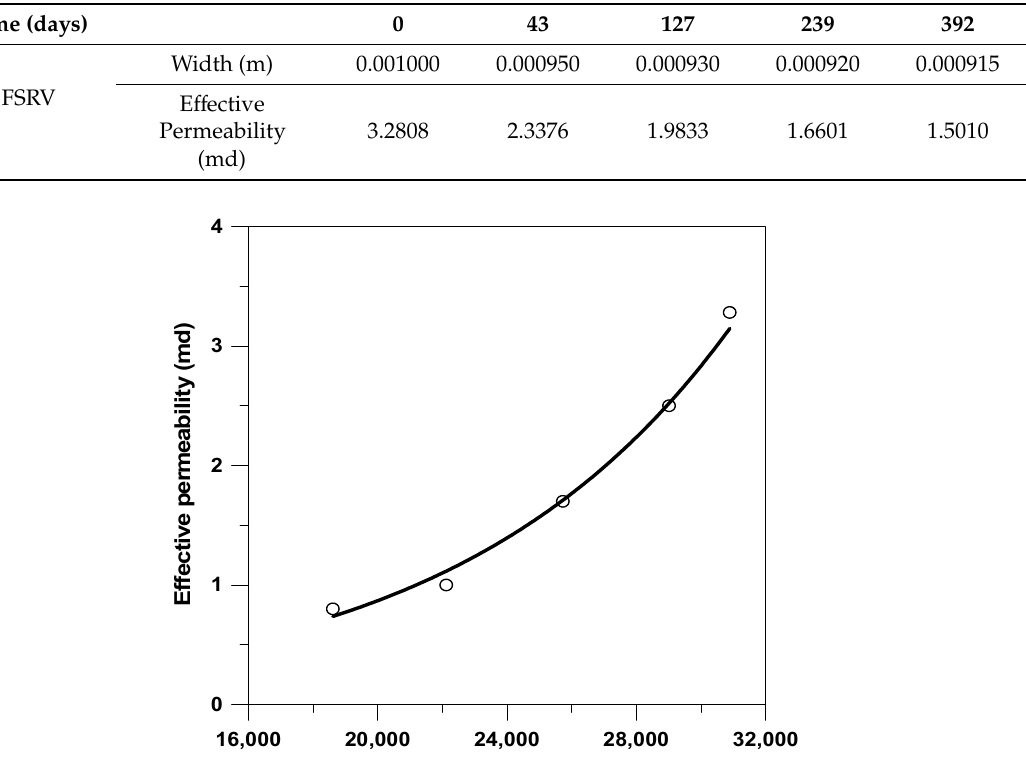
Table 4. Hydraulic fracture width and effective permeability change according to production time within FSRV.